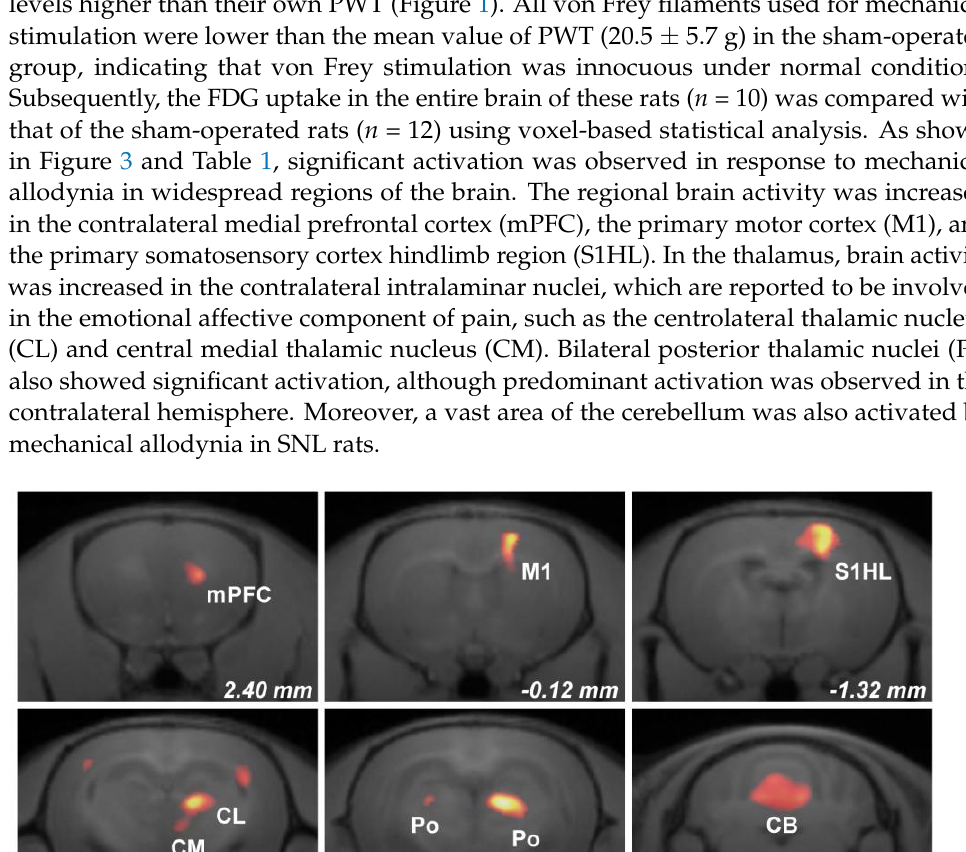
Figure 2. Behavior test for the assessment of mechanical allodynia one day before the FDG PET scan. Bilateral hind paw withdrawal thresholds (PWT) for von Frey filaments stimulation were assessed in the sham-operated (closed bar, n = 12) and SNL (open bar, n = 10) rats. The data are presented as mean ± standard deviation of the mean (SD). *, p < 0.05, two-tail unpaired t- tests.